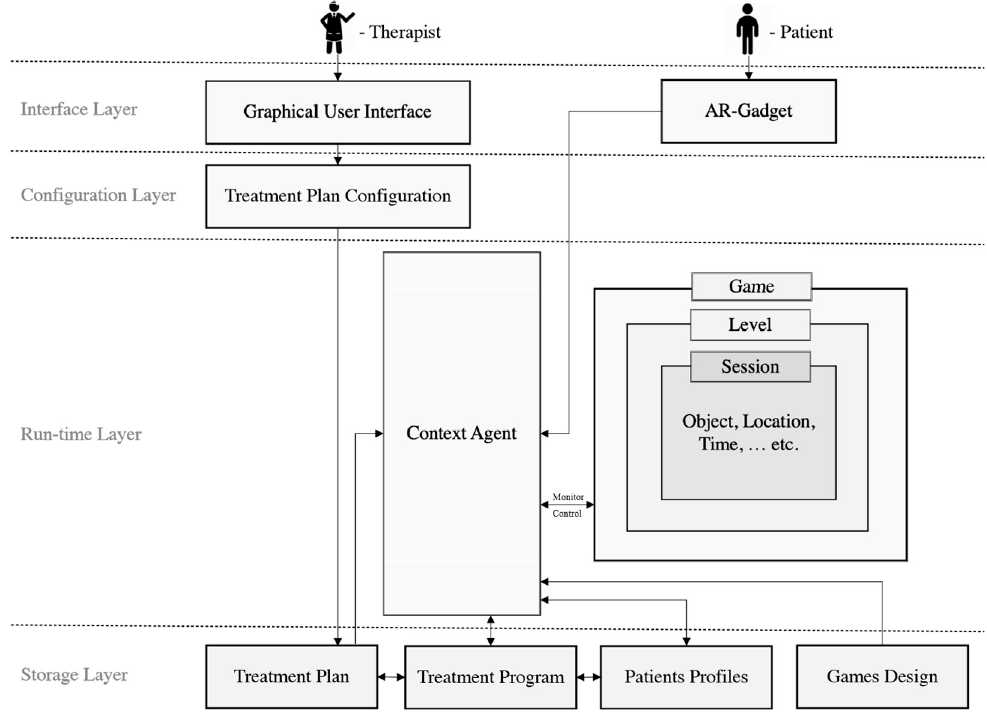
Figure 1. The general conceptual model for Augmented Reality (AR)-Therapist.